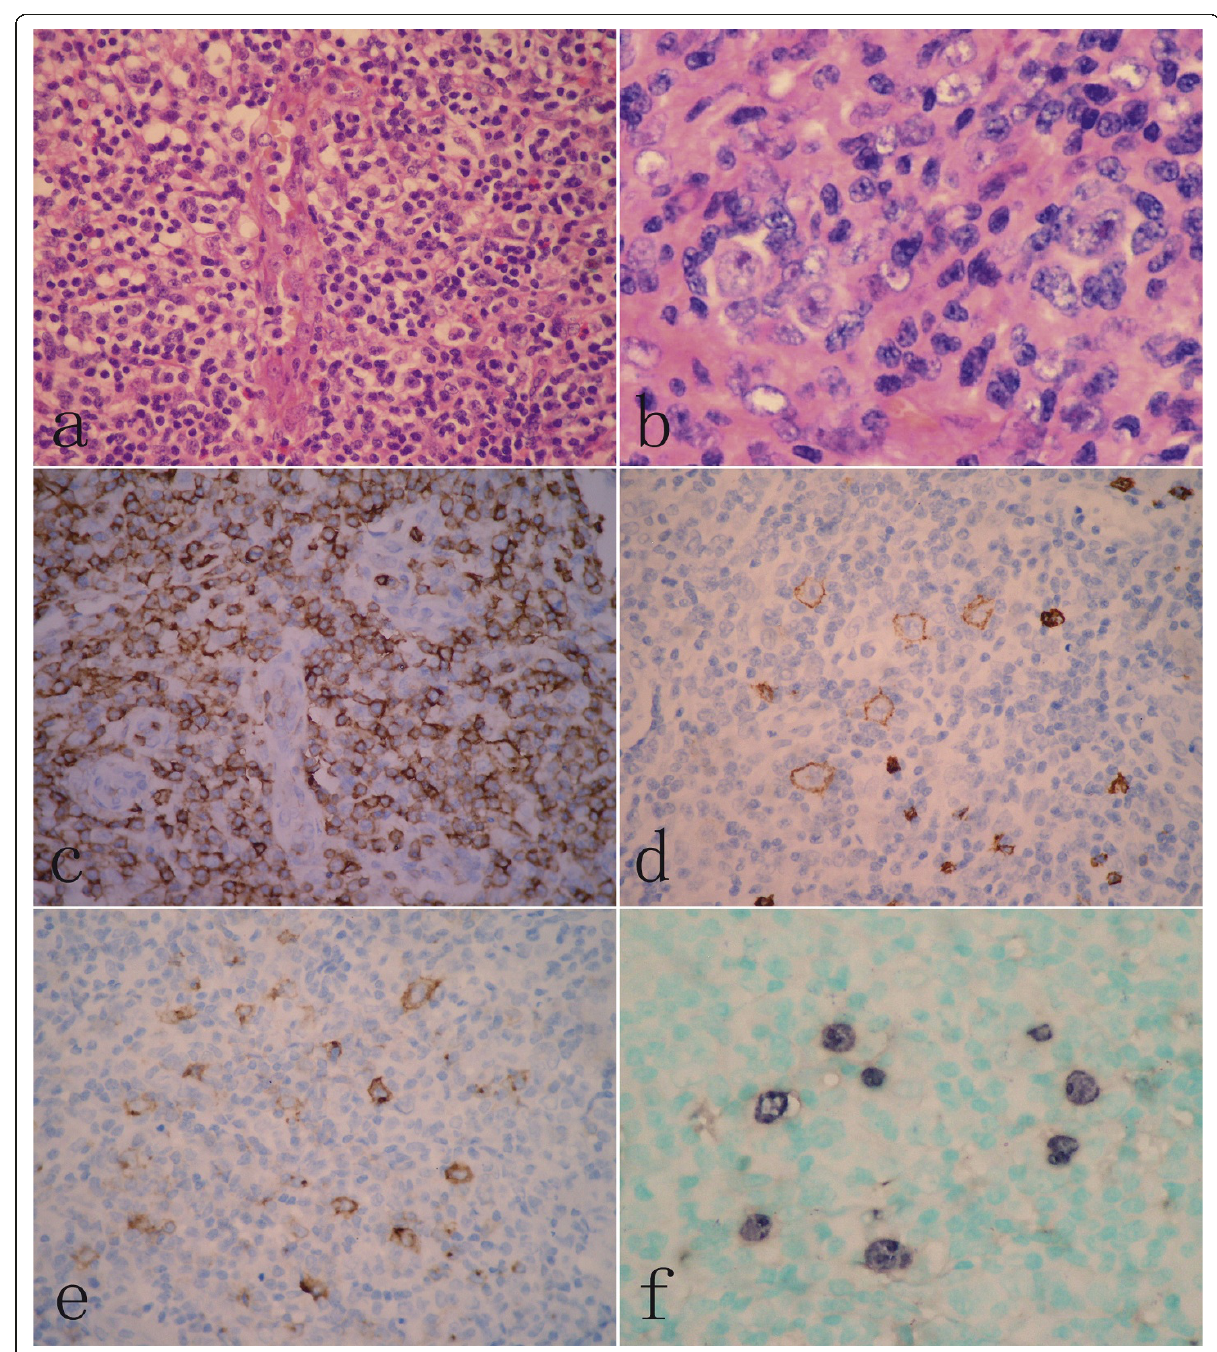
Figure 1 Histopathological findings of lymph node at the initial presentation . (A) The architecture of lymph node was effaced by a diffuse polymorphic infiltration composed of small- to medium-sized lymphoid cells, immunoblastic cells and scattered eosinophils around high- endothelial venules. (B) Multinucleated cells with eosinophilic nucleoli resembling Reed-Stemberg (RS) cells could be observed in the lymph node. (C) Immunohistochemical examination revealed that infiltrated small to medium-sized lymphoid cells were diffusely positive for CD3, but large immunoblast-like cells and RS-like cells were positive for CD20 (D) and CD30 (E).These larger cells were also positive for EBER by in situ hybridization (F).(A, H&E staining, with original magnification ×400; B, H&E staining, with original magnification ×600; C-E, immunohistochemical staining, with original magnification ×400; F, EBER-in situ hybridization, with original magnification